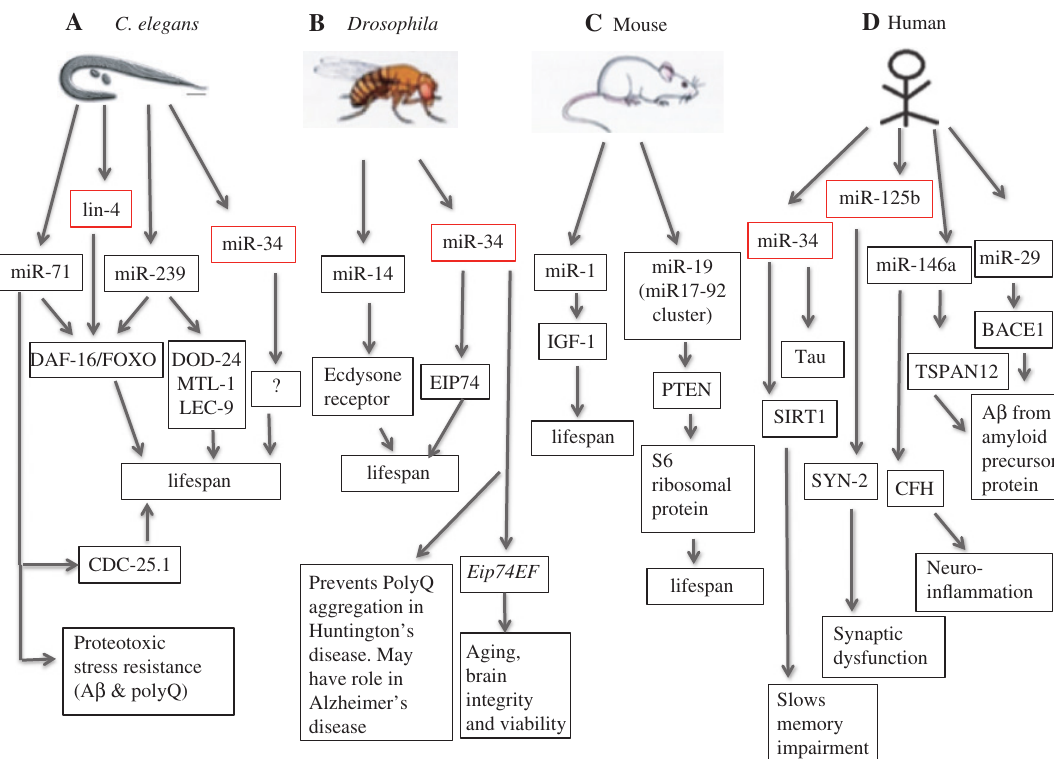
Figure 1: Association of miRNAs with aging and age-related diseases in different model organisms. Model of the association between selected miRNAs, predicted targets, and phenotypes on life span or age-related diseases. The arrows denote functional or expression relationships that have identified between miRNAs and their targets or with specific phenotypes on life span or age-associated disease states. Note that the arrows only specify association but not the type of regulation (i.e. positive vs. negative regulation). This list is not exhaustive – see text and Table 1 for further details. Conserved miRNAs with already confirmed cross-species function in aging or age-related diseases are offset and highlighted in